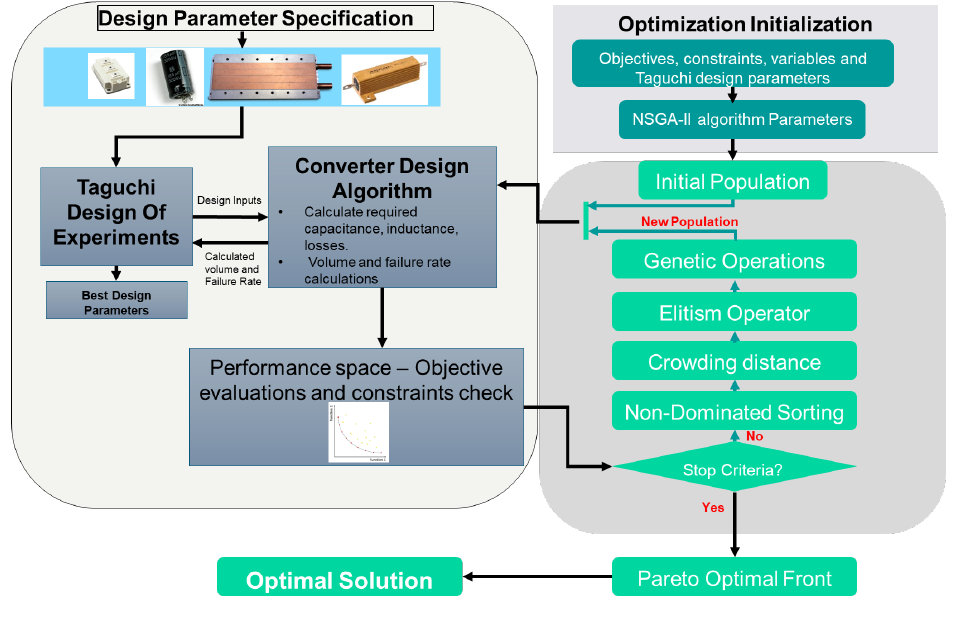
Figure 7. Framework of Design Automation for MMC.